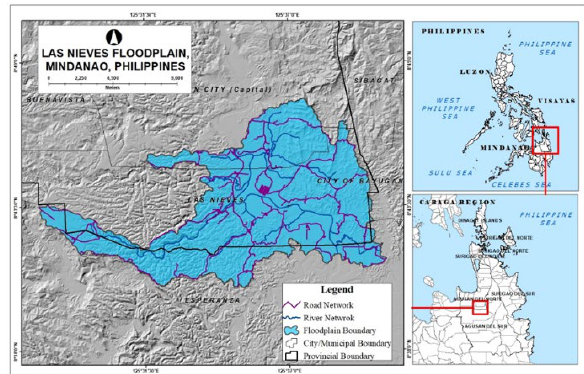
Figure 1. Las Nieves floodplain area, Agusan del Norte, Mindanao, Philippines.